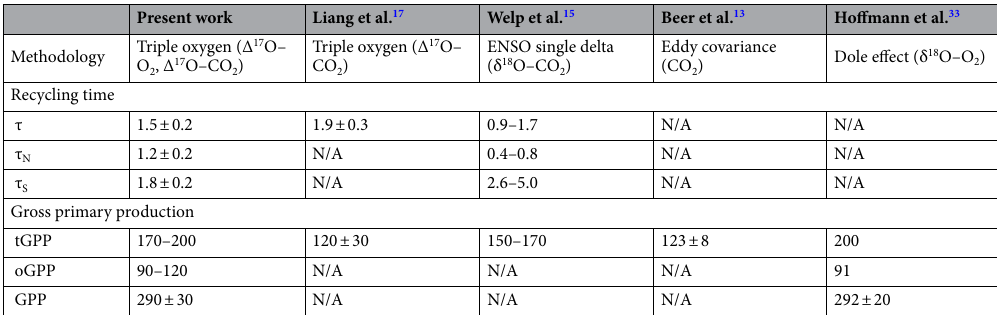
Table 2. Estimated GPP (PgC/year) and recycling time τ (year) for this work and the